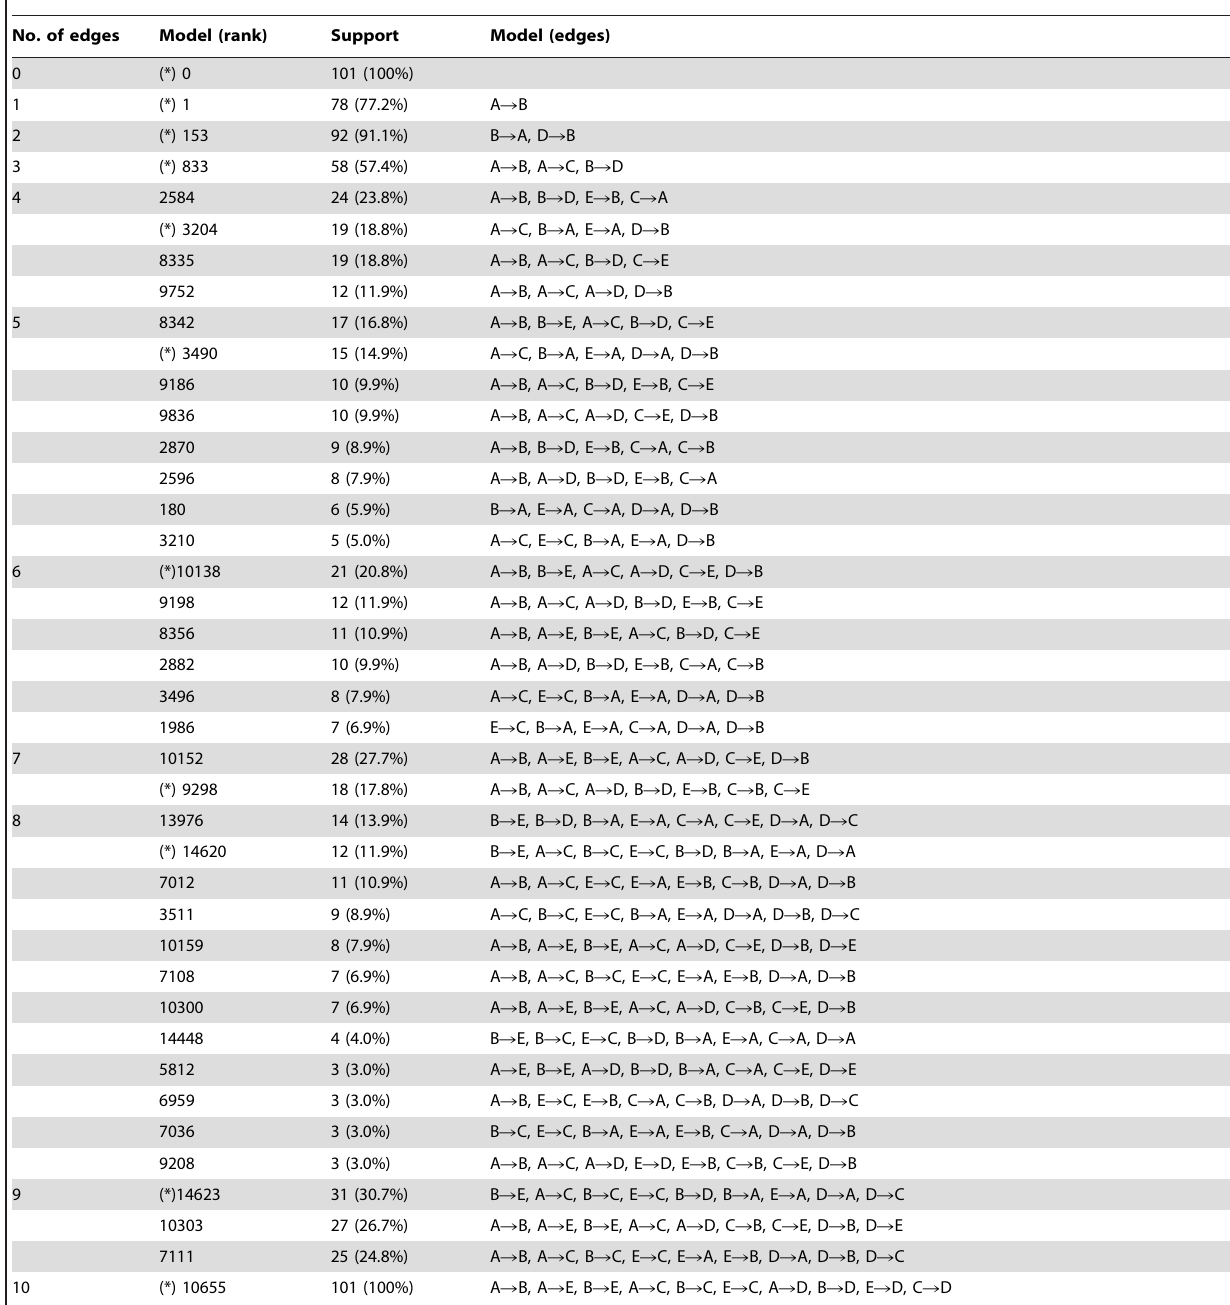
Table 3. Statistics on the individual best-models for BIC scores in